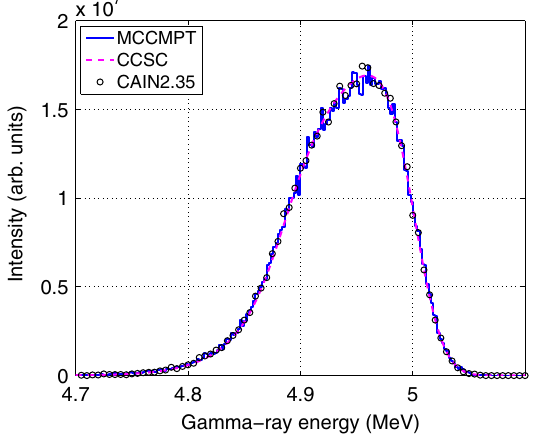
FIG. 10. Compton gamma-ray beam energy spectra generated using computer codes MCCMPT , CCSC , and CAIN2.35 . The stairs plot represents the spectrum simulated using the code MCCMPT , the dashed line represents the spectrum calculated using the code CCSC , and the circles represent the one using the code CAIN2.35 . The electron-beam energy and rms energy spread are 400 MeV and 0.2%, respectively. The electron-beam horizontal emittance is 10 nm rad, and the vertical emittance is neglected. The laser wavelength is 600 nm with negligible photon beam energy spread. The gamma-ray beam is collimated by an aperture with a radius of 12 mm located 60 meters downstream from the collision